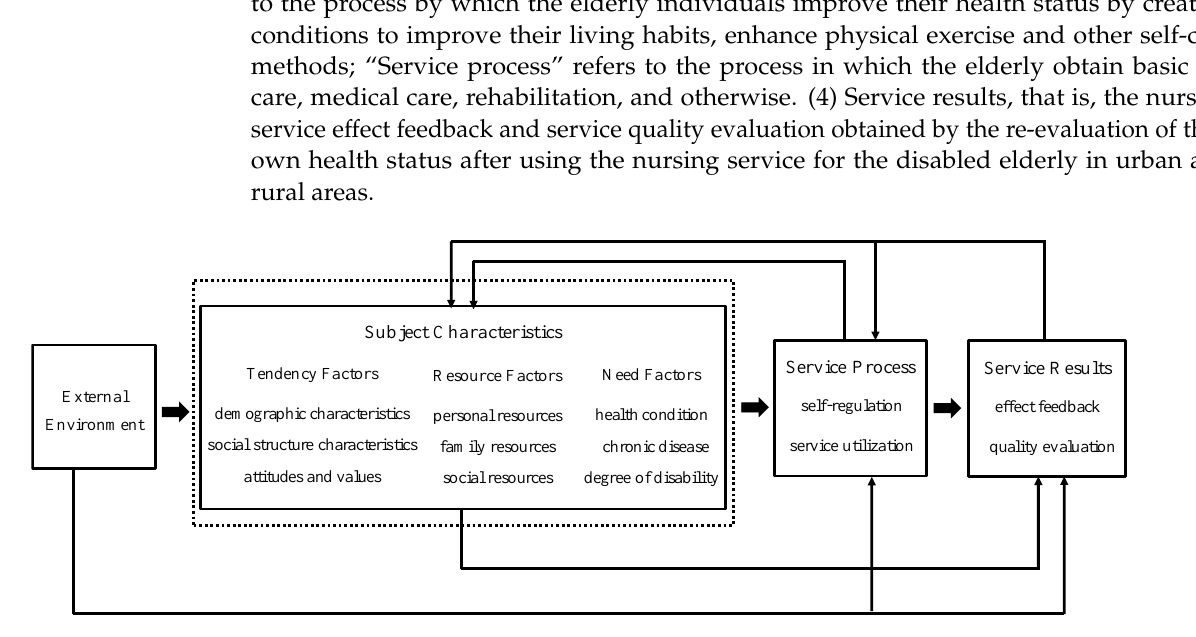
Figure 1. The theoretical analysis framework of the factors affecting the demand for care services for the disabled elderly in urban and rural areas.